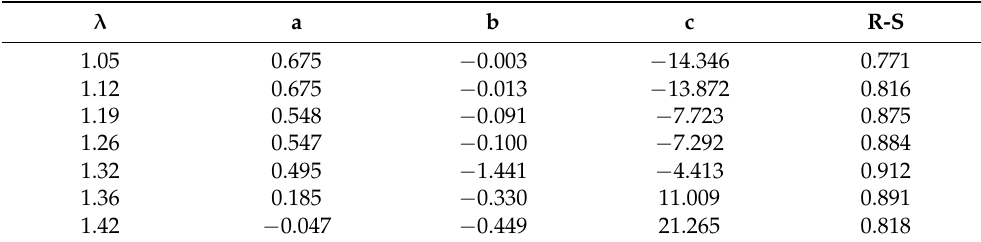
Table 6. Fitting parameters of CA05 and PMAX distribution under different λ .